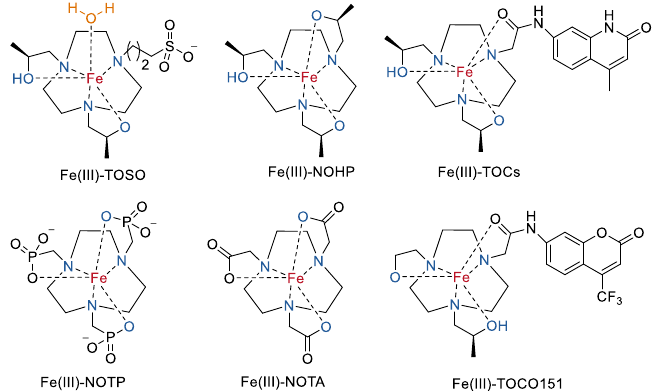
Figure 7. Chemical structures of mononuclear Fe(III) complexes based on TOB derivatives [55 – 57].